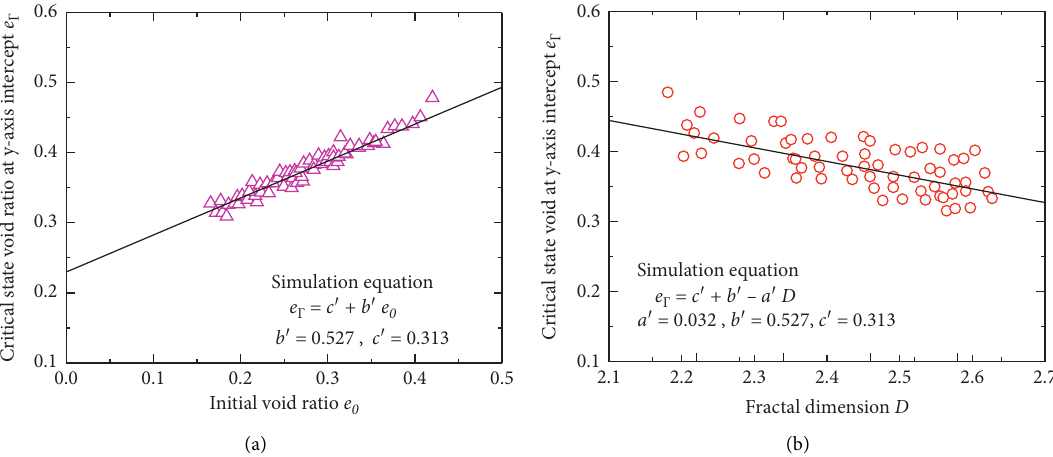
Figure 5: The properties of the granular materials. (a) The relation between the intercept e between the intercept e Γ and the fractal dimension D